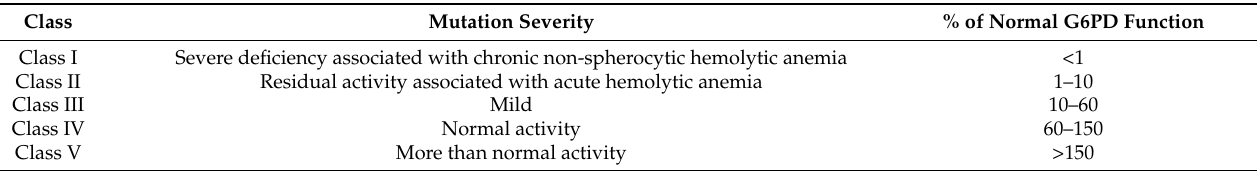
Table 1. Classification of G6PD